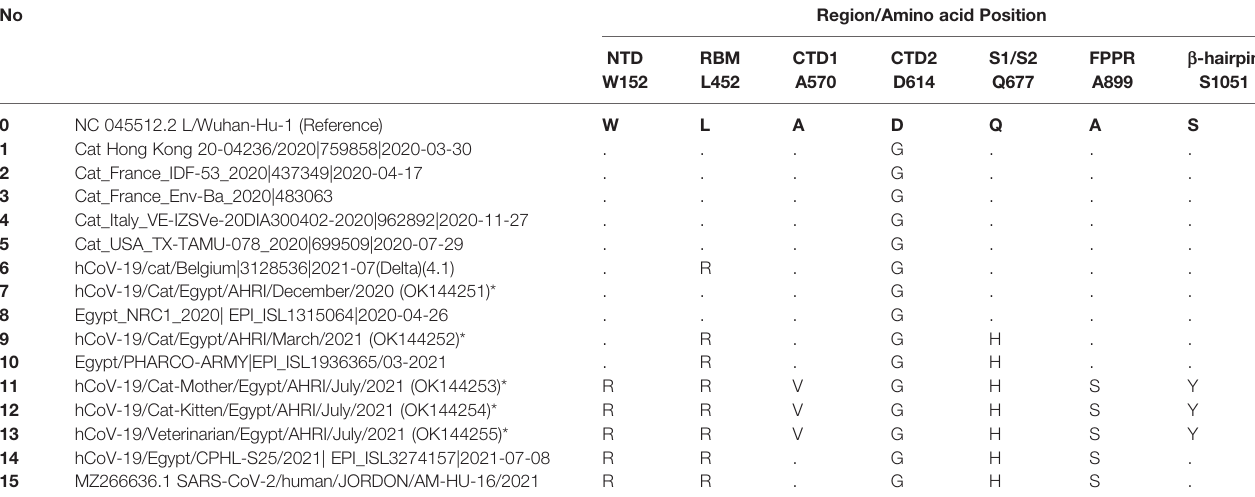
TABLE 1 | Amino acid substitutions in the sequenced samples in comparision to some circulating variants in human and